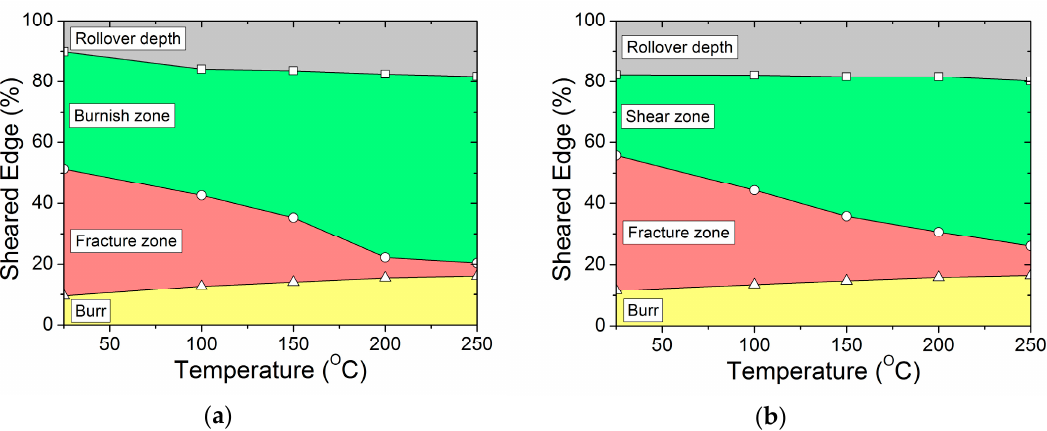
Figure 7. Relationship between characteristic dimensions of sheared edge (%) and temperature at ( a ) 10% clearance and ( b ) 20% clearance.